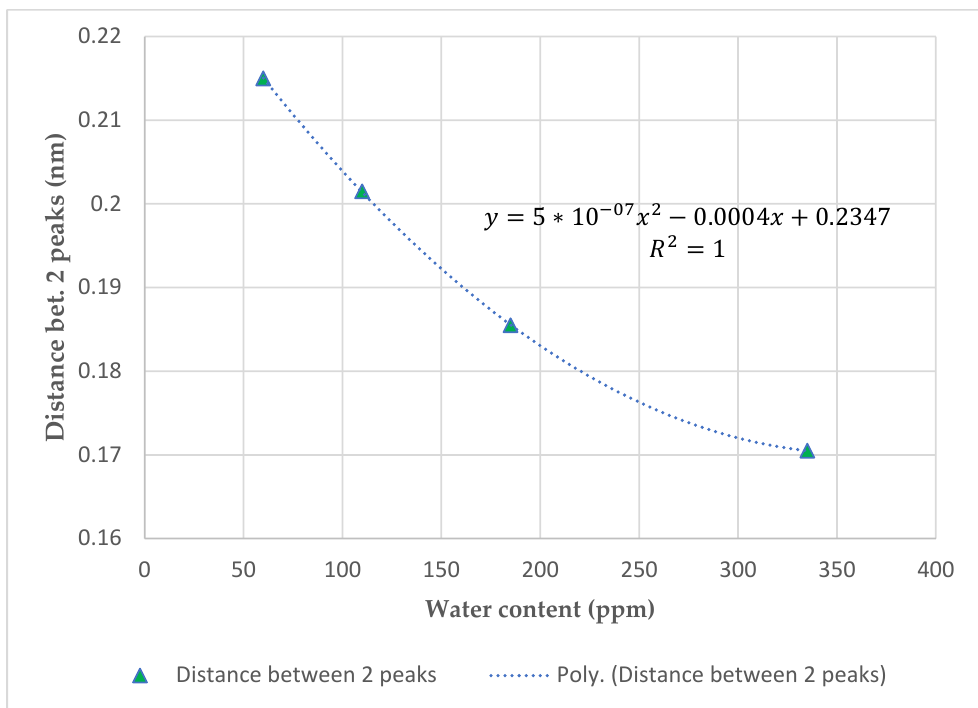
Figure 14. Wavelength domain feedback curves for different exposure times to Midel 7131 water content after insertion of FOS.